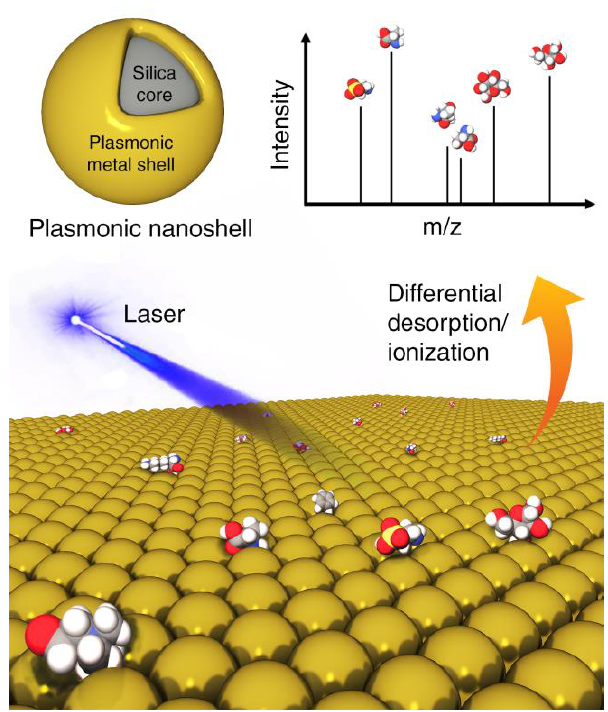
Figure 5. Inorganic nanoparticles, such as plasmonic nanoshells, enable enhanced ionization of small molecules in matrix-assisted laser desorption/ionization mass spectrometry (MALDI-MS) for metabolomics applications.